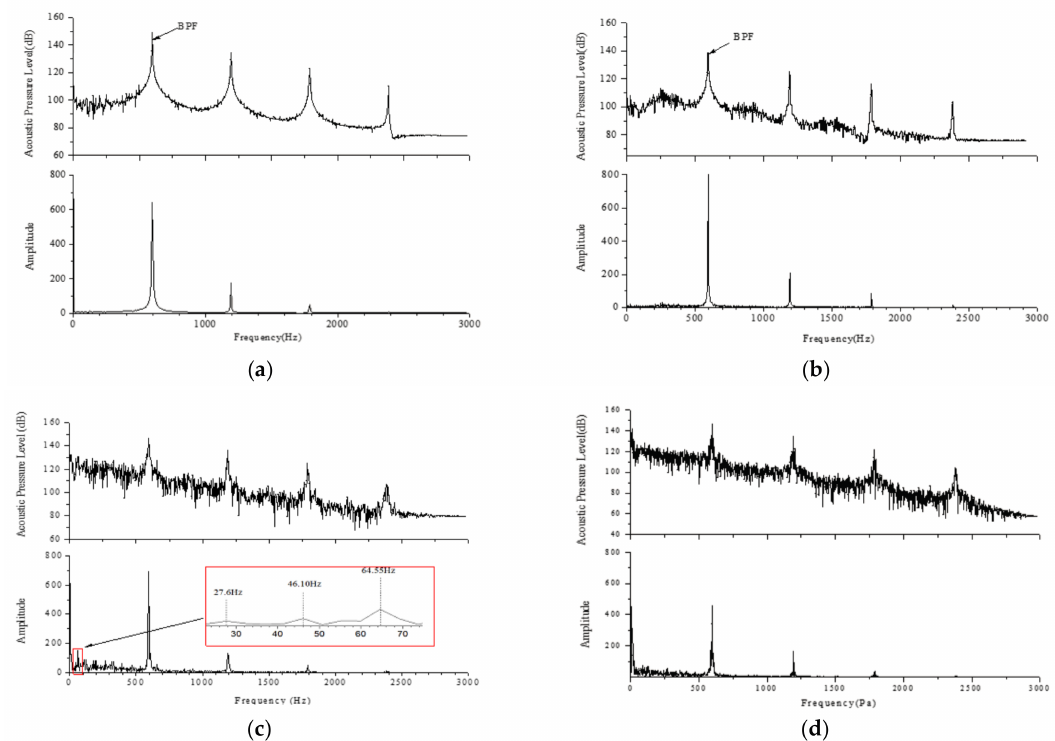
Figure 11. Noise spectrum of the acoustic pressure level and amplitude at four conditions: ( a ) the design condition; ( b ) near the stall inception condition; ( c ) the development of stall inception condition; and ( d ) deep rotating stall